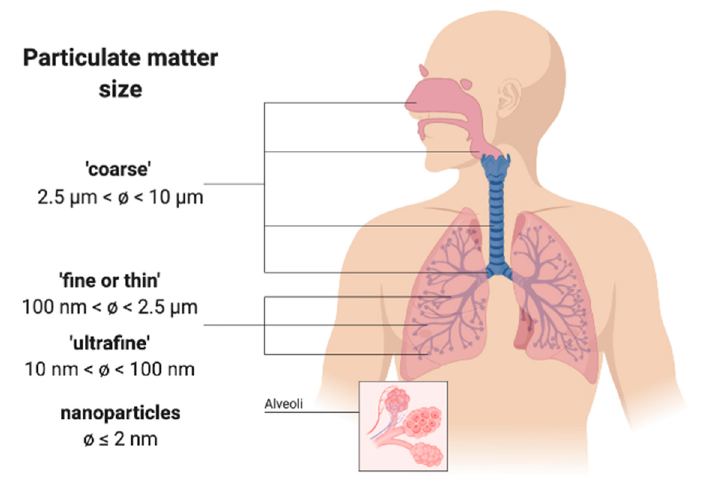
Figure 5. The particulate matter of various sizes can penetrate the respiratory tract, in some cases up to the pulmonary alveoli.